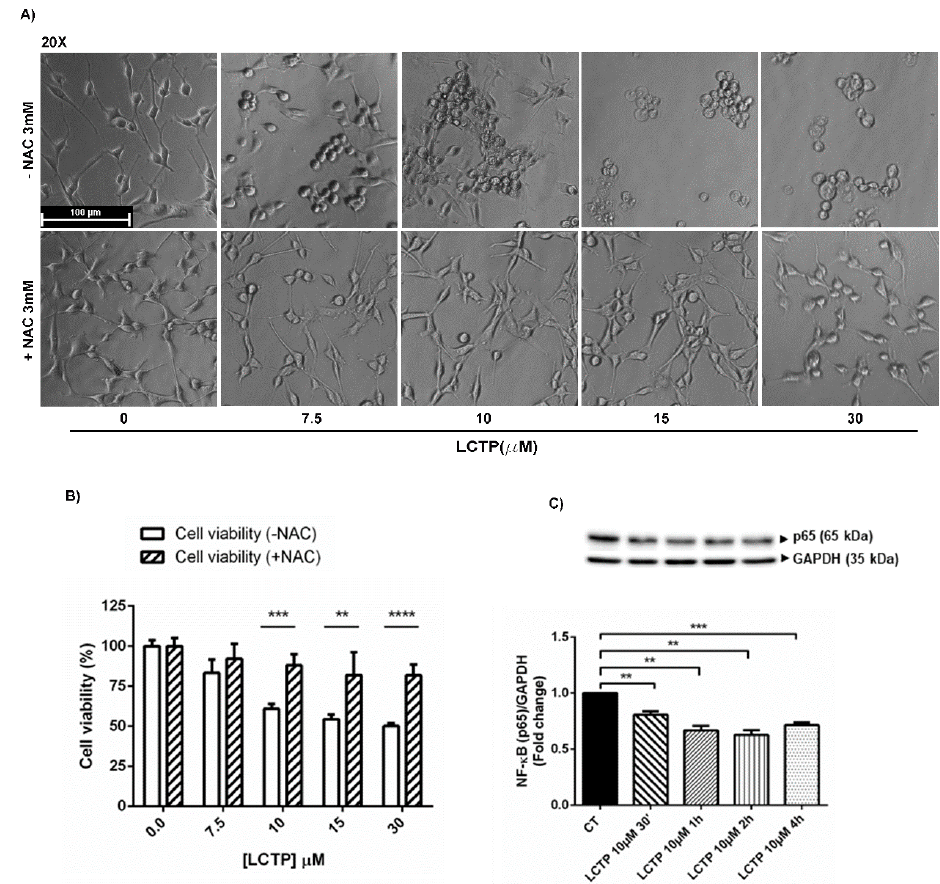
Figure 4. ( A ). Effect of pre-treatment with ROS scavenger NAC 3mM for 4 h on